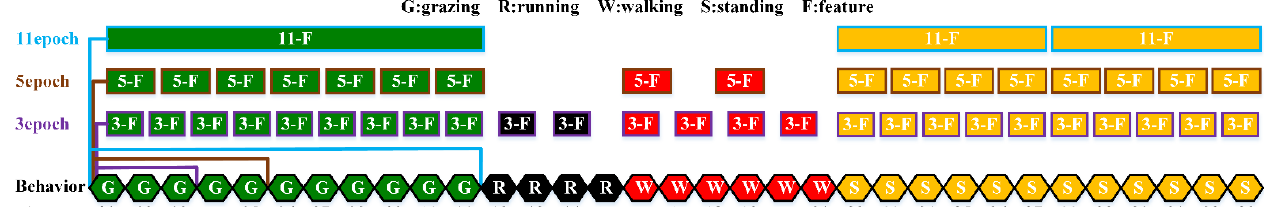
Figure 9. The features calculation process of three time windows (3, 5 and 11 s) on the 33 s observed behavior segments.